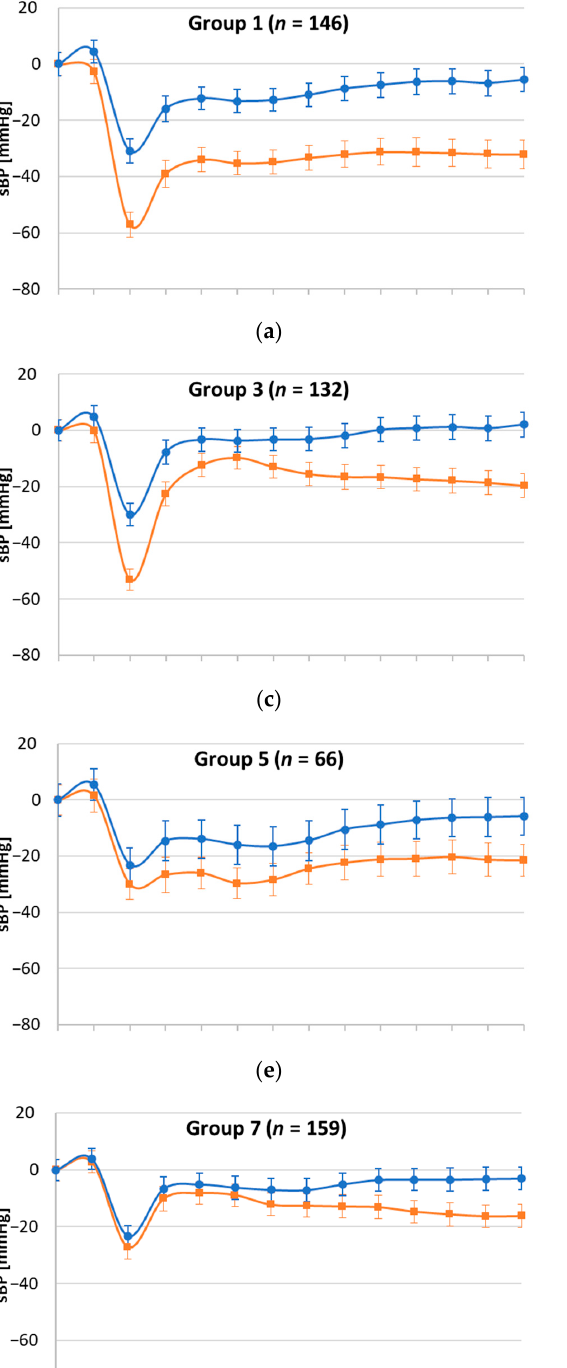
(Base) Abbreviations: OR: odds ratio; CI: confidence interval; ADL: activities of daily living; IADL: instrumental activities of daily living. Groups 2 and 6 were very small ( n = 16 and 18, respectively) and there was little statistical power to detect statistically significant differences in AS morphology. The 132 participants who at W1 had displayed a pattern of immediate and late defi- cits (Group 3) also seemed to have an improved longitudinal pattern, with only 23.5% and 21.2% of participants having those deficits at W3. In this group, the prevalence of self- reported hypertension reduced by 15.9%, with a 14.4% increase in antihypertensives and an 18.2% reduction in OI. Again, in this group there were no significant longitudinal as- sociations with negative clinical outcomes. In Group 4 ( n = 366), the only morphological difference visually seemed to be an im- provement in the initial drop by W3 (26.5% versus 100% at W1), with similar recoverabil- ity. The prevalence of self-reported hypertension reduced by 5.8% with a 38.0% increase in antihypertensives and there was an 11.5% reduction in OI. There was a 5.8% increase in frailty status and there was a statistically significant longitudinal association with new falls: OR 1.36, 95% CI: 1.07–1.72, p = 0.012 (Table 2). Group 5 ( n = 66), originally characterised by stabilisation and late deficits, seemed to have a more preserved longitudinal morphological pattern (Figure 2) with a suggestion of a better recovery (37.9% and 45.5% recurrence of deficits, respectively). As regards clin- ical characteristics, there was a 22.7% increase in frailty. There was a statistically signifi- cant longitudinal association with new cognitive decline: OR 1.63, 95% CI: 1.12–2.36, p = 0.011 (Table 2). In Group 7 ( n = 159), originally characterised by late deficit only, there was only 32.1% of that deficit by W3. The prevalence of self-reported hypertension reduced by 9.5% with a 17.0% increase in antihypertensives and there was an 15.7% reduction in OI. There were two new cases of Parkinson’s disease in this group. There was a statistically significant longitudinal association with new falls: OR 1.47, 95% CI: 1.03–2.09, p = 0.034 (Table 2).